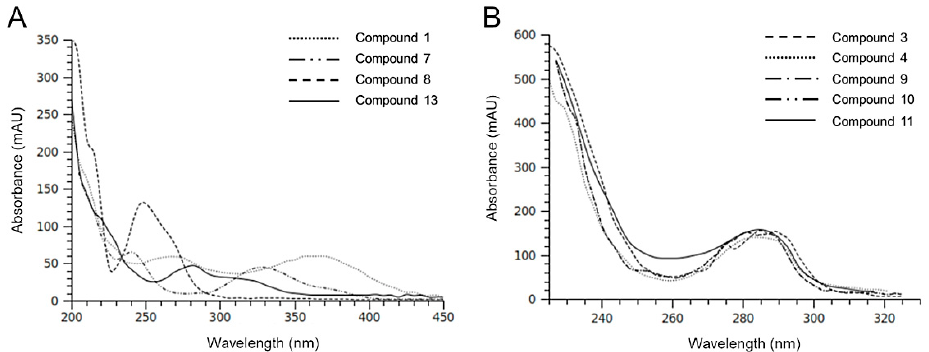
Figure 2. UV-Vis spectra of the main compounds detected in HIE/n. In ( A ) and ( B ) the numbering scheme reflects that reported in Figure 1 and Table 2. The UV-Vis spectra of 9 and 10 ( B ) are exactly overlapped.